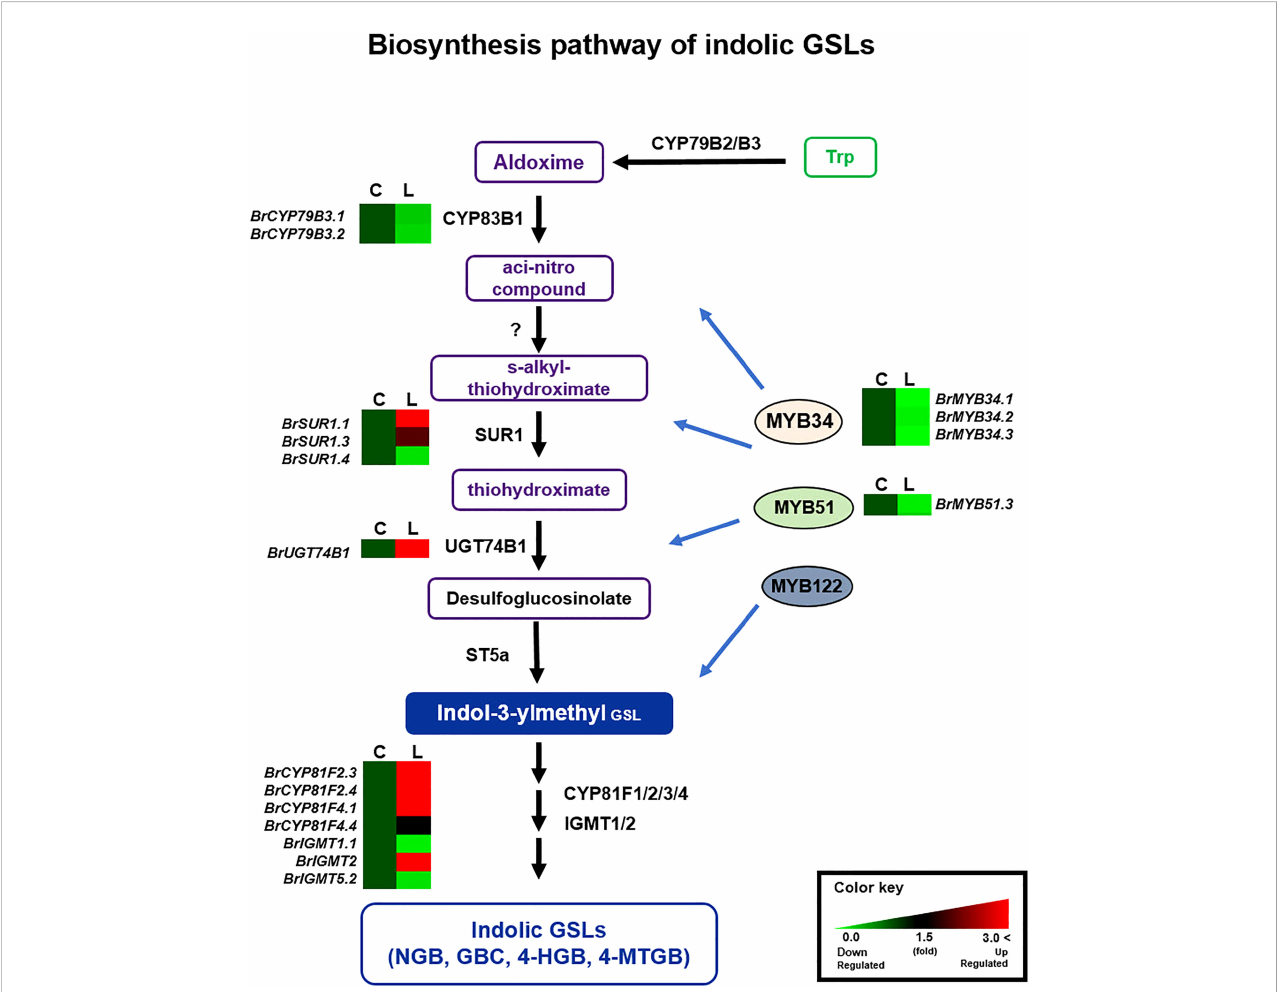
FIGURE 5 Comparison of expression pro fi les of GSL metabolic genes involved in indolic GSL biosynthesis. Schematic representation of indolic GSL metabolic pathways and expression patterns of indolic GSL pathway genes in ‘ Chiifu ’ and ‘ LP08 ’ . The indolic GSL biosynthetic pathway begins with core structure formation from precursor amino acids, such as tryptophan (Trp), by catalytic enzymes such as CYP79B2. Black letters between paths refer to genes associated with each step. B . rapa MYB TFs such as BrMYB34s, BrMYB51s, and BrMYB122 boost the expression of indolic GSL metabolic genes. Expression pro fi les of BrMYB34s, BrMYB51s, BrMYB122s , and downstream indolic GSL metabolic genes, exhibited complex differences between ‘ Chiifu ’ and ‘ LP08 ’ . For comparative heatmap analysis between ‘ Chiifu ’ and ‘ LP08 ’ , the level in ‘ Chiifu ’ was set to 1 and the relative level of each gene in ‘ LP08 ’ is presented on the right side. C: Chiifu, L: